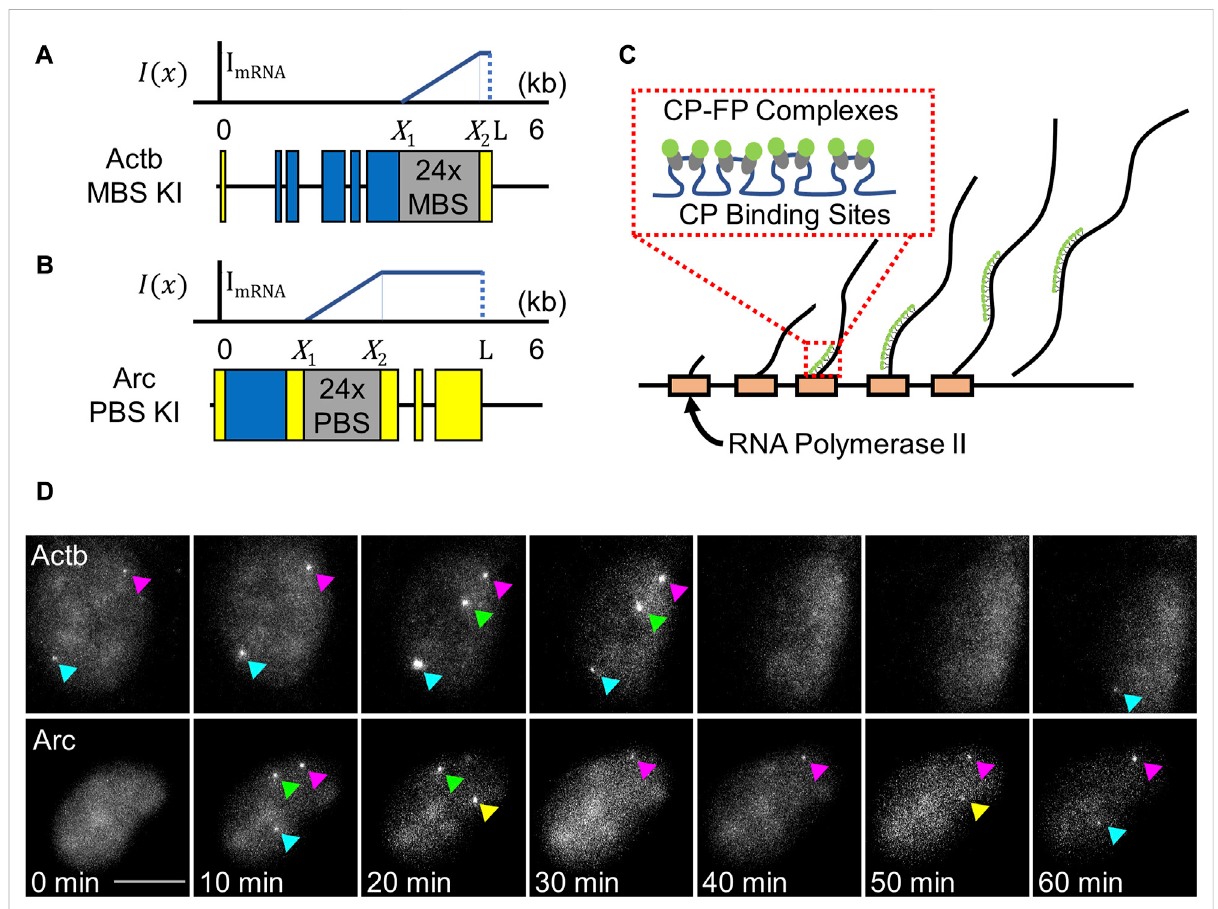
FIGURE 1 Imaging transcription using MS2 and PP7 stem – loop systems. (A,B) Schematic of the Actb-MBS (A) and Arc-PBS (B) knock-in constructs. The fl uorescence intensity of a nascent RNA increases as Pol II transcribes the binding sites from X intensity remainsconstant (gray: bindingsites,blue:codingsequence,yellow: untranslated region). (C) SchematicofnascentRNAsatatranscription site. Multiple capsid proteins fused with fl uorescent protein (CP-FP) complexes are bound to a single nascent RNA. (D) Maximum z-projected time-lapse images of serum-stimulated MEFs. Transcription sites are observed as bright points (arrowheads) in the nucleus. Scale bar, 10 μ